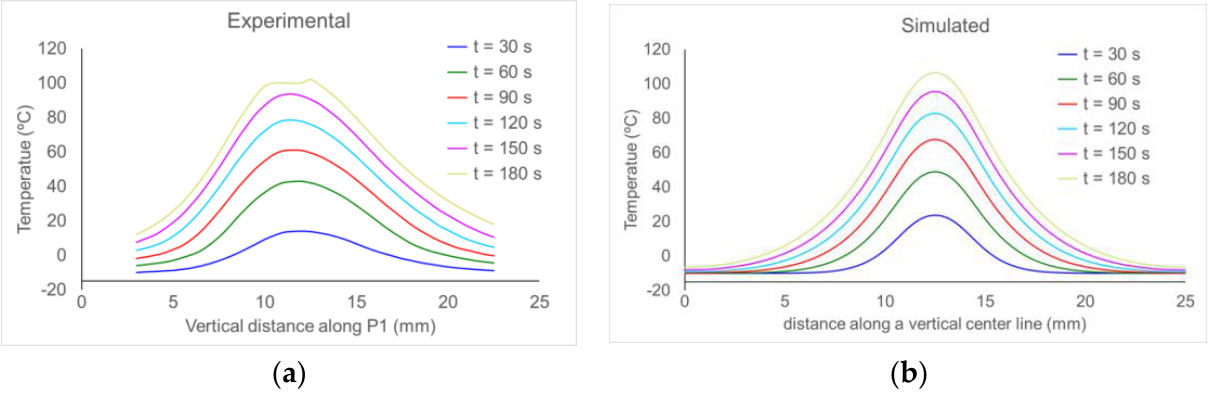
Figure 5. Temperature profile along P1 (Figure 2) on heated AA6061. Experimental ( a ) and simu- lated ( b ). P = 10.9 W, V = 0 m/s.